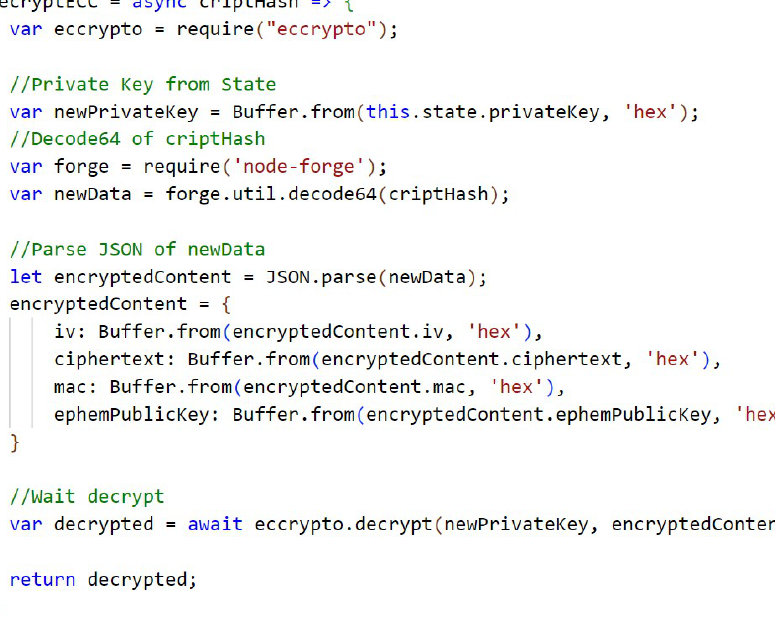
Figure A13. Decrypt